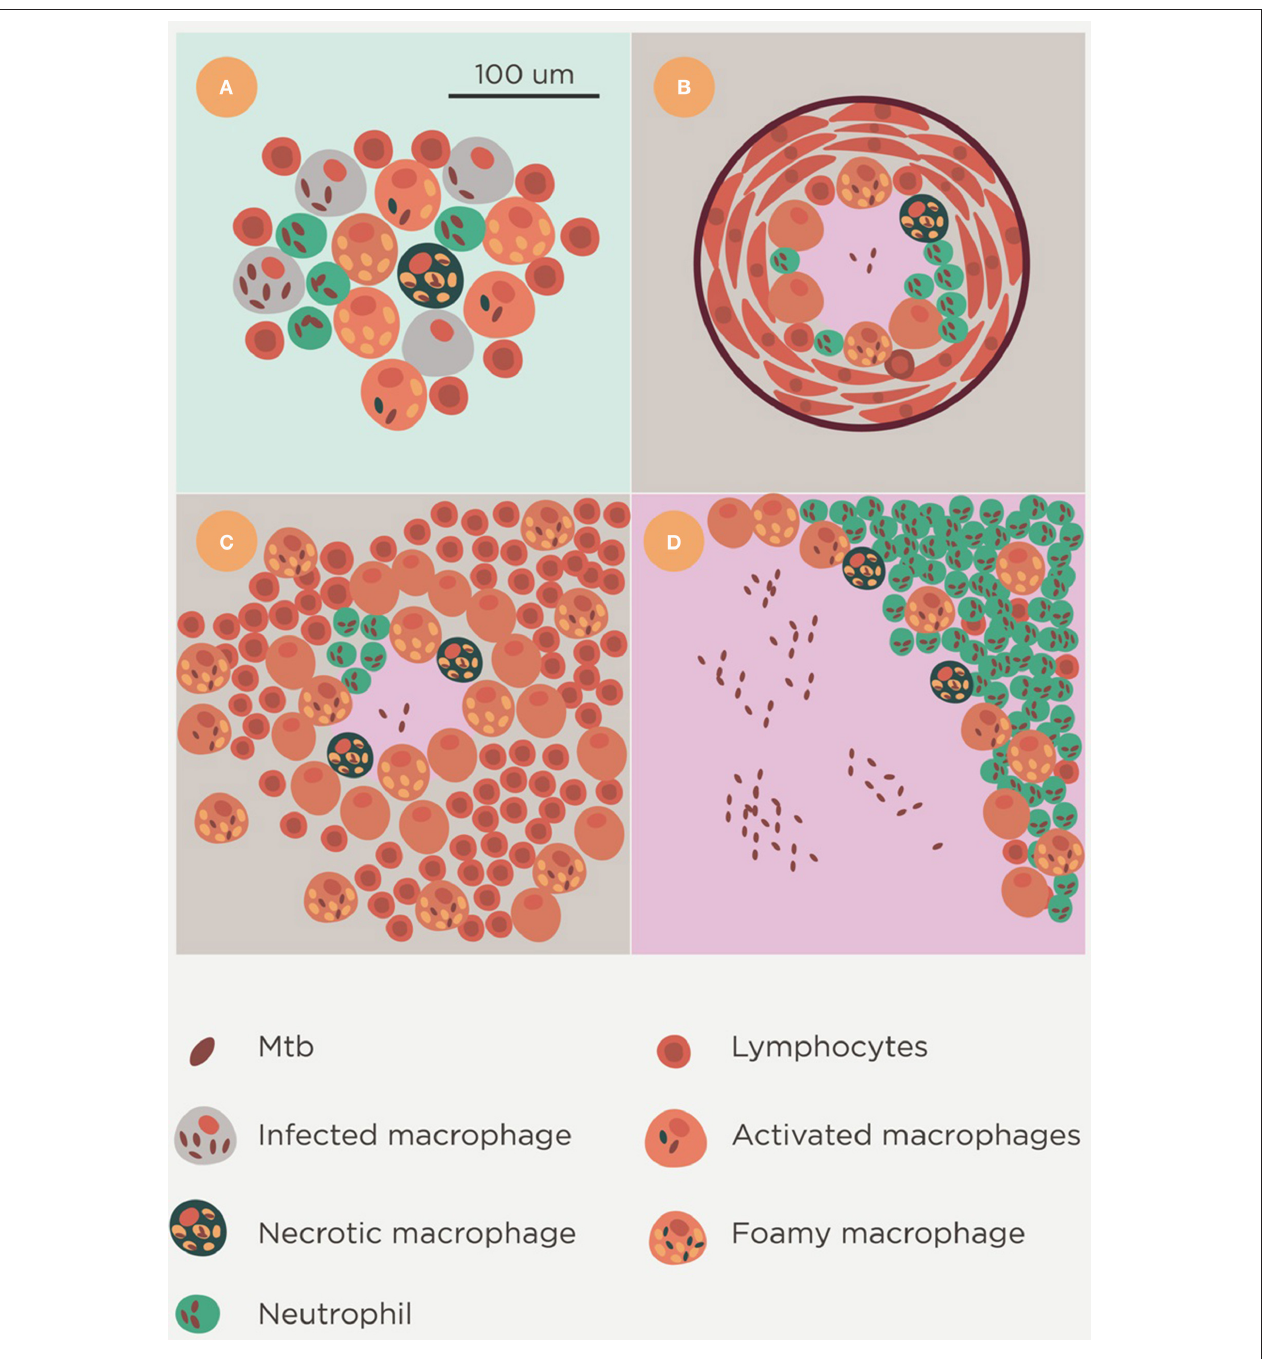
FIGURE 7 | Lesion spectrum of Mtb infection. Histological evolution after Mtb infection. Initial foci containing a mixture of neutrophils, macrophages and lymphocytes (A) are soon controlled by the encapsulation process and either calcify (B) or progress with constant reactivation of the bacillary load in foamy macrophages of the neighborhood. This is typical in the murine infection (C) . These lesions could fall into the category of proliferative lesions. Exudative lesions are characterized by the large-scale infiltration of neutrophils, a high bacillary burden, and the presence of massive necrosis (D)